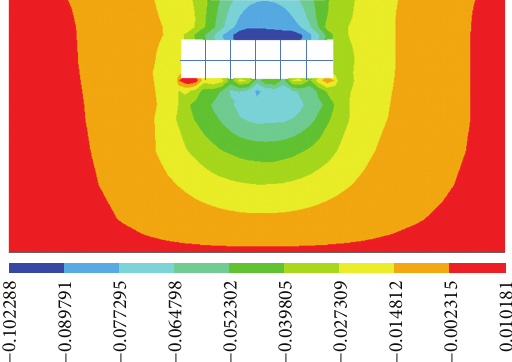
Figure 1: Vertical displacement nephogram of Method 1.